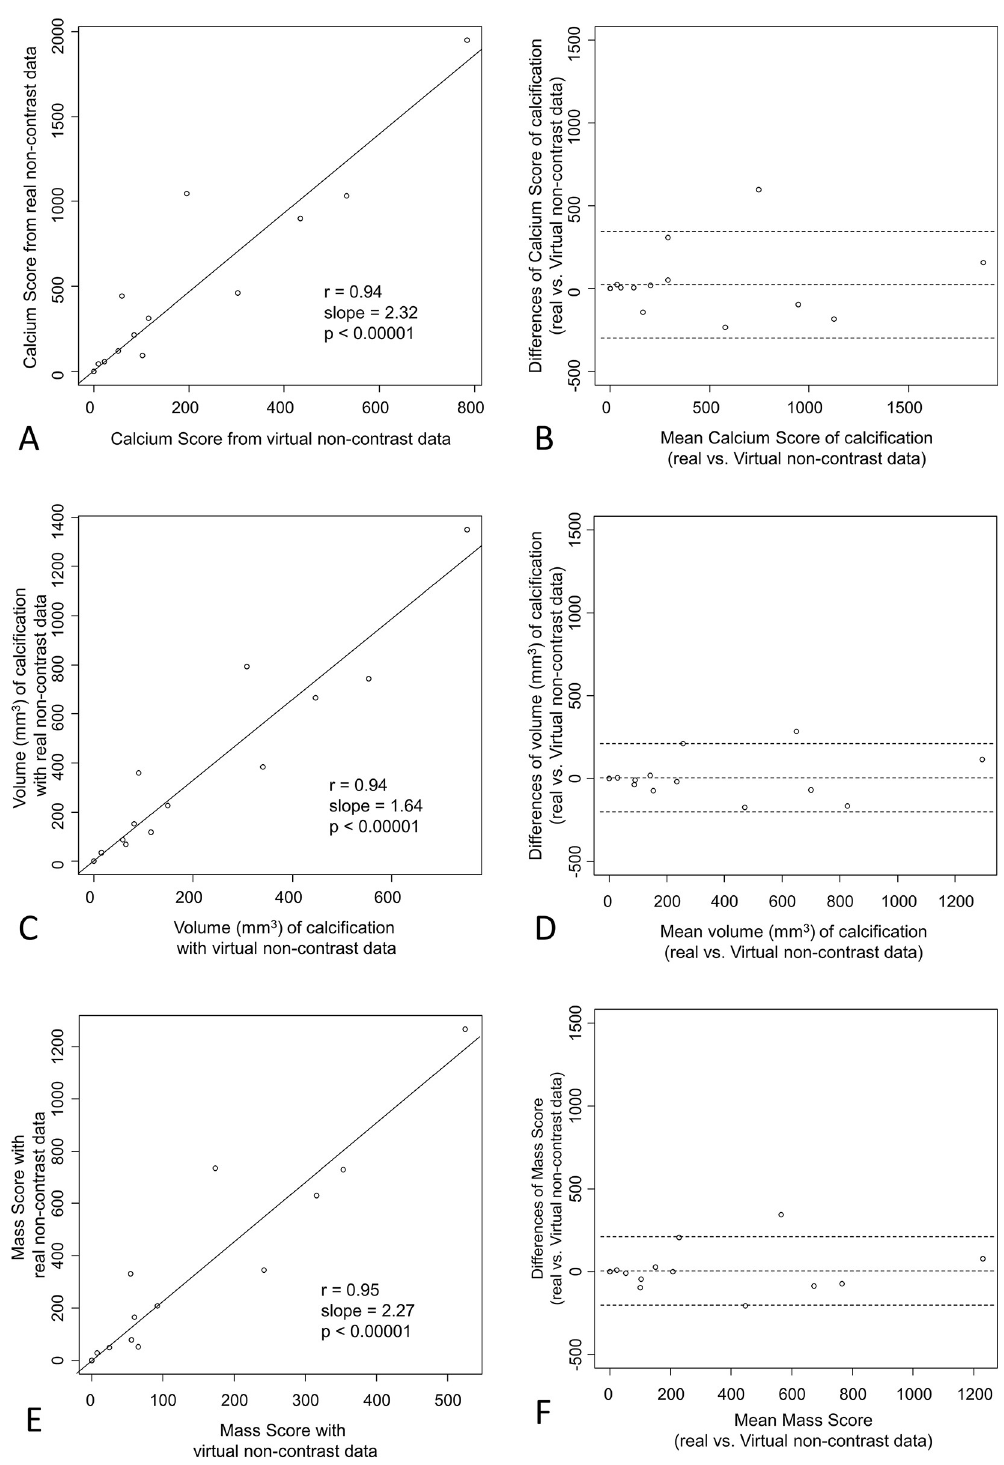
Fig 2. Results of correlation and Bland-Altman analysis. A illustrates the correlation between detected Calcium Score using virtual non-contrast and real non-contrast data. Agreement of both methods is shown in B with a Bland-Altman plot; the values of the Calcium Score from virtual non-contrast have been corrected by the slope. C shows the correlation of the measured volume of calcification between virtual non-contrast and real non-contrast data. The agreement of both methods for determination of the volume of calcification is illustrated in D with a Bland-Altman plot; the volume from virtual